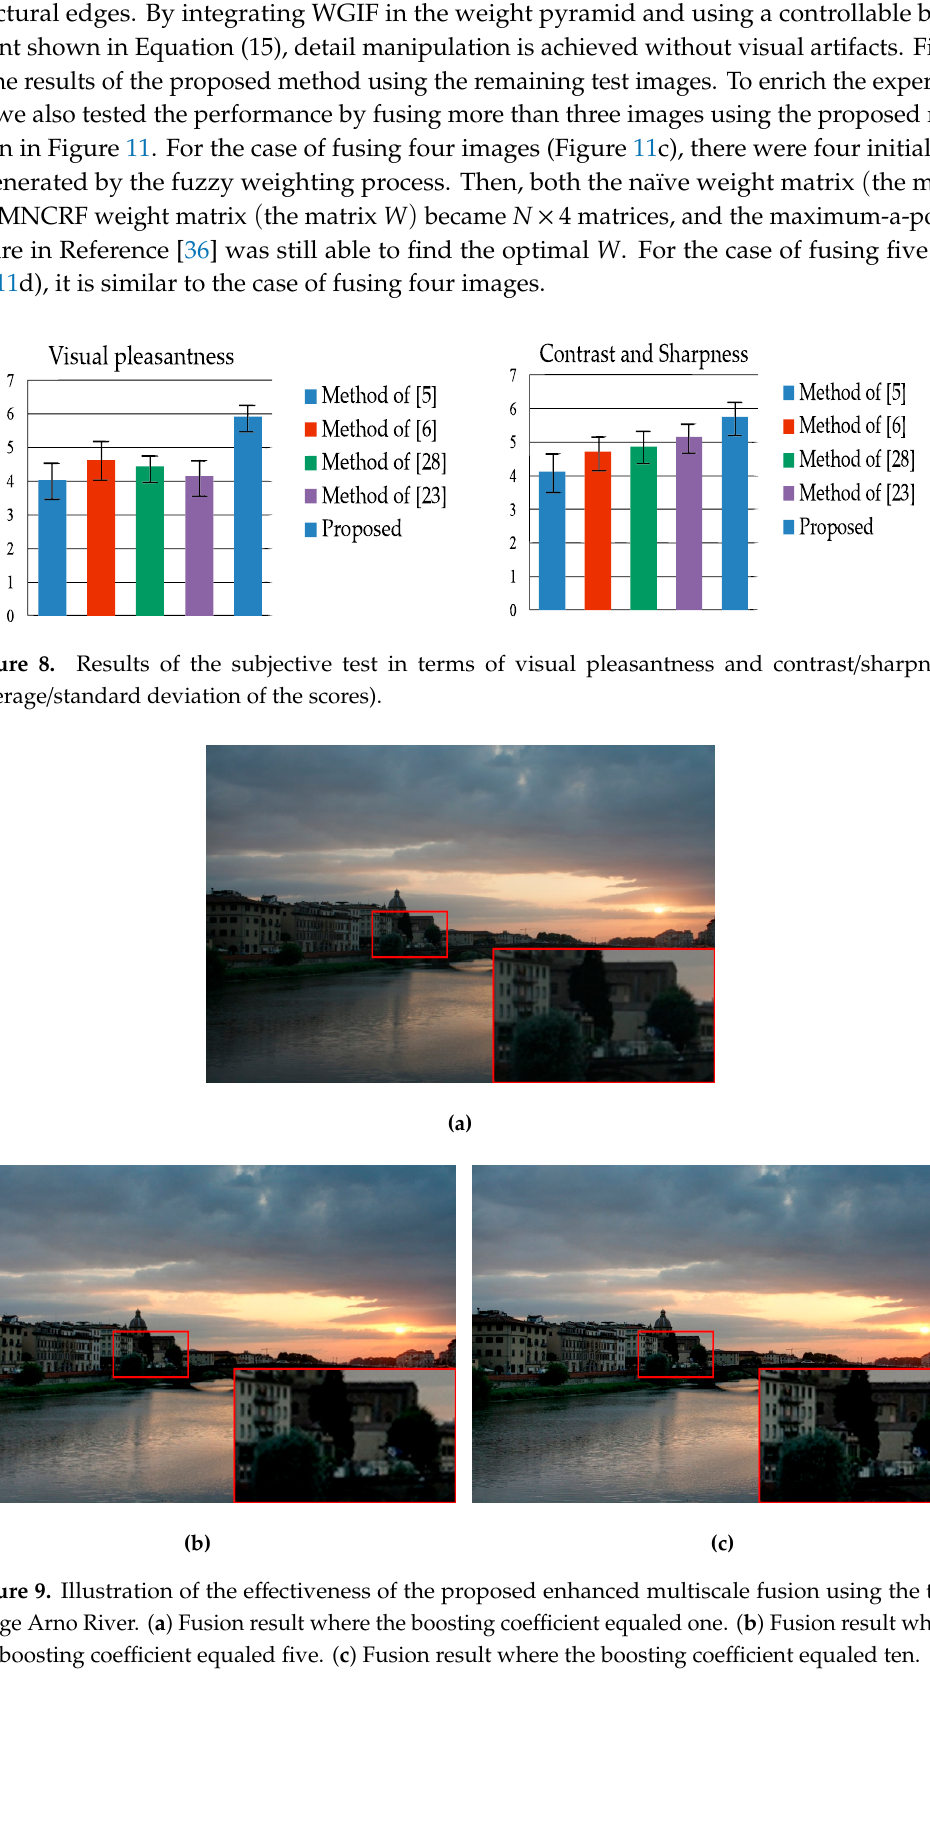
Figure 7. Visual comparison of the exposure fusion results using the test image Laurentian Library . ( a ) Results from the method in Reference [5]. ( b ) Results from the method in Reference [6]. ( c ) Results from the method in Reference [28]. ( d ) Results from the method in Reference [23]. ( e ) Results from the proposed method. The enlarged versions of the red rectangles are provided to illustrate the subtle differences.